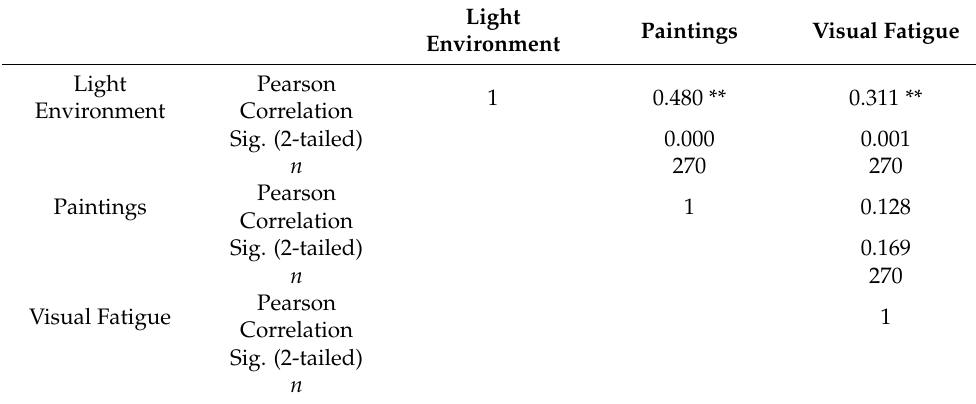
Table 7. Pearson correlation analysis of the light environment, paintings, and visual